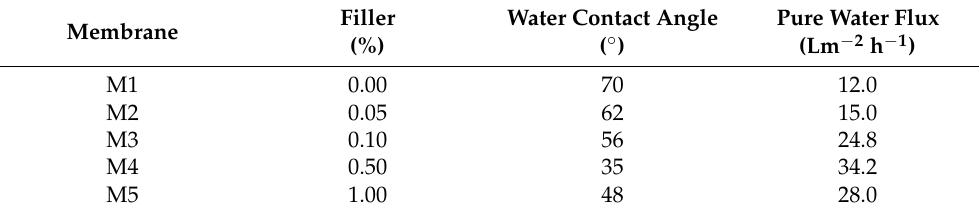
Table 11. Composition and water contact angle and flux of MMMs.